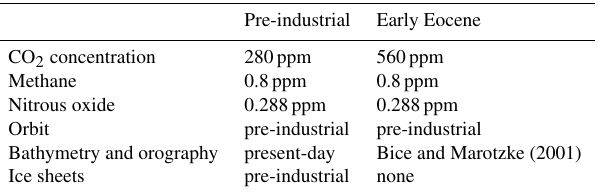
Table 1. Boundary conditions for the early Eocene climate simula- tions and for pre-industrial conditions simulations.